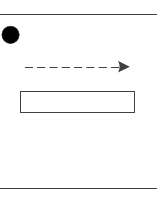
Figure 10. Magnetically sensitive orientation of the fl ux gate